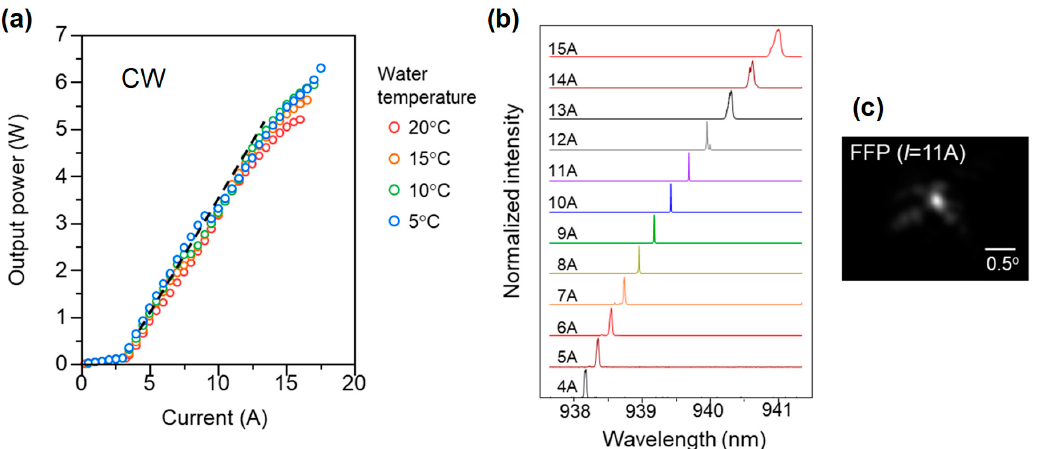
Figure 13. ( a ) CW laser output characteristics of a PCSEL having structure III, at different water temperatures. ( b ) Spectra at different injection currents. ( c ) Far field patterns at 11 A(~4 W). Reprinted by permission from Springer Nature, Nature Materials [16], 2019.